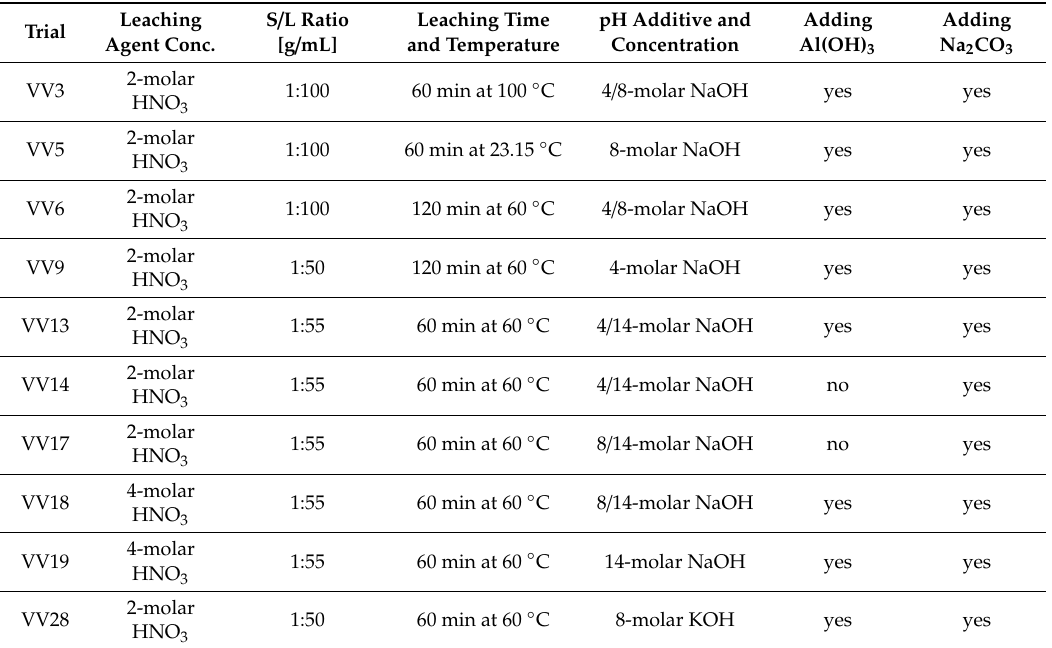
Figure 9. Overview on the lithium yields reached in the pre-trials by using HNO 3 as solvent. Table 5. HNO 3 parameter combinations applied in the pre-trials.